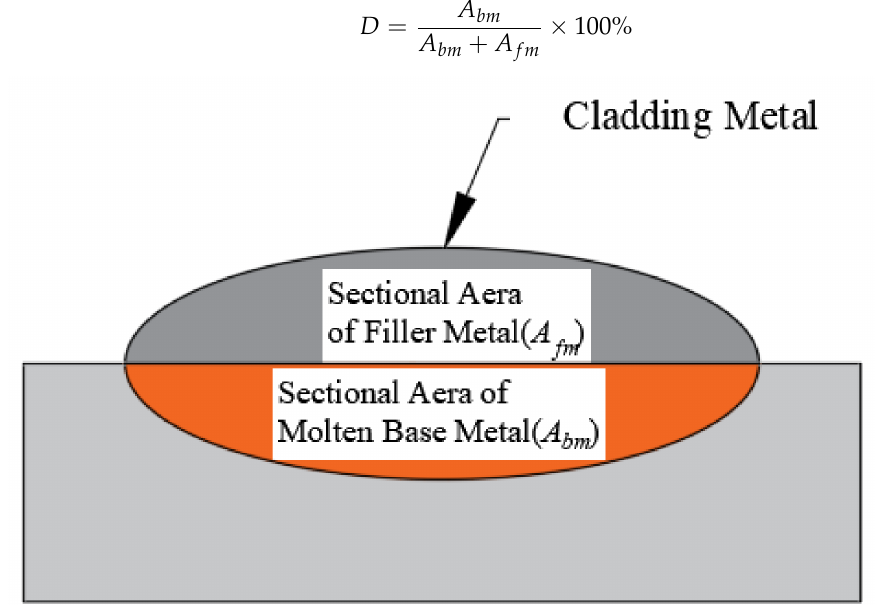
Figure 1. Schematic diagram for calculating the cross-sectional area of the weld dilution ratio D